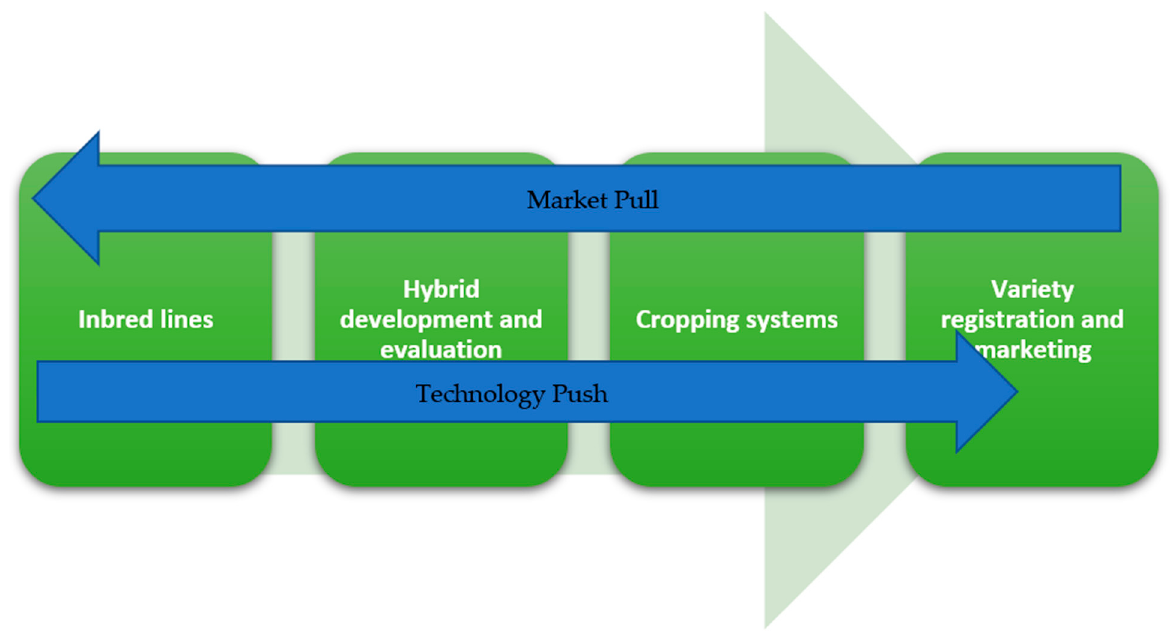
Figure 4. The two flows of information, Market pull and Technology push managed by product management. The product development pipeline in a breeding program runs from inbred lines to variety